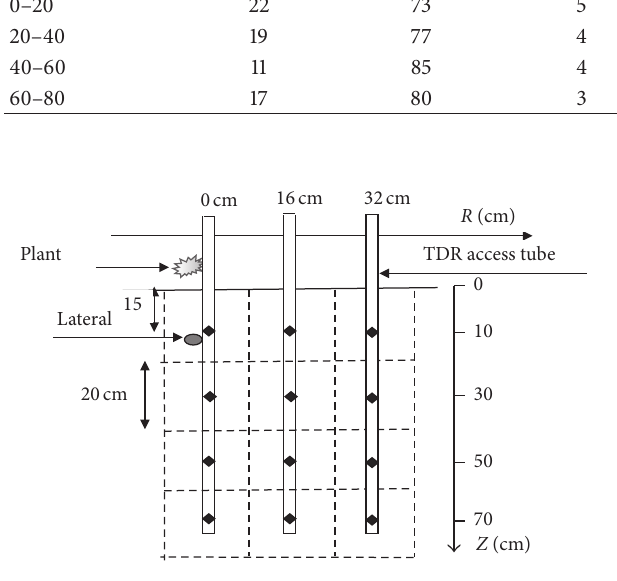
Figure 2: Profile of a measurement site.